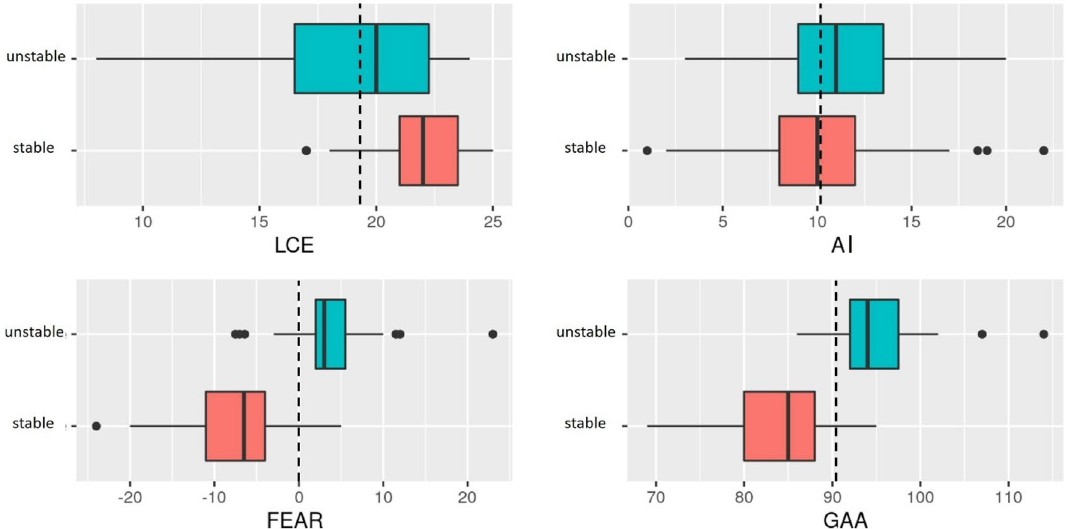
Figure 5. Boxplots of the radiographic parameters for the two groups. The dashed lines indicate the optimal cutoff values for predicting instability. It is obvious that LCEA and AC angle are not suitable to prediction of